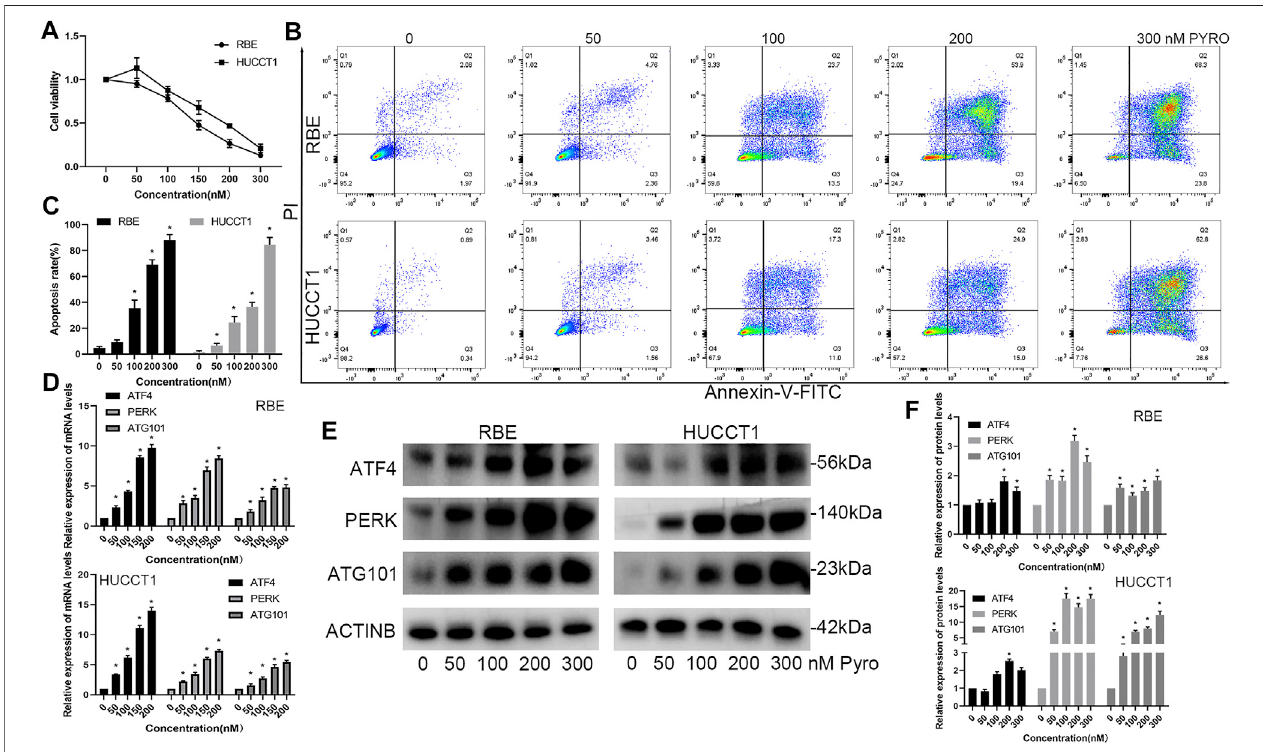
FIGURE 8 | PYRO-PDT induces apoptosis and up-regulates the expression of ATG101 and unfolded protein response markers. (A) The effect of different concentrationsofPYRO-PDT(0 – 300 nM,10J/cm 2 )ontheviabilityofRBEandHUCCT1cellsina96-wellplatewasdetectedbyCCK8assay. (B) AftertreatingRBEand HUCCT1 cells in a 6-well plate with different concentrations of PYRO-PDT for 4 h, the apoptosis level was detected by Annexin-V-FITC/PI staining and fl ow cytometry. (C) is a histogram of the early and late apoptosis rates of different groups in (B) . (D) After processing the RBE and HUCCT1 cell lines in 6-well plates with different concentrations of PYRO-PDT for 4 h, the mRNA levels of ATF4, PERK and ATG101 were determined by qRT-PCT. (E) Determine the protein levels of ATF4, PERK and ATG101 by western blot after the same treatment as in (D) . (F) is a histogram of the relative expression levels of proteins in each group in (E) . * p <